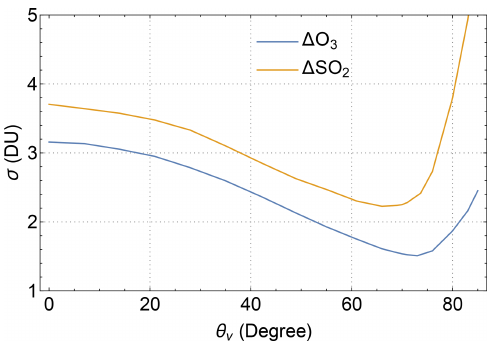
Figure 17. Noise levels, i.e., standard deviations ( σ ) of O 3 and SO 2 errors ( (cid:49) ), contributed from the random noises in EPIC spectral measurements. The SO 2 noise estimate is for a layer at an altitude 11km above sea